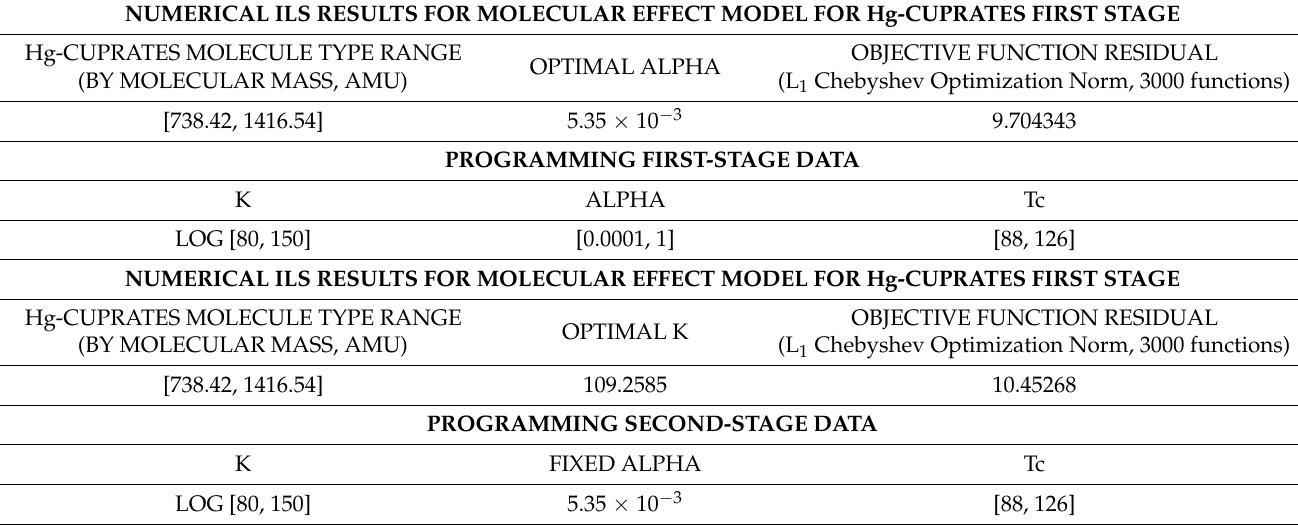
Table 4. Numerical results for the ILS molecular effect model for Hg-cuprate HT superconductors. NUMERICAL ILS RESULTS FOR MOLECULAR EFFECT MODEL FOR Hg-CUPRATES FIRST STAGE